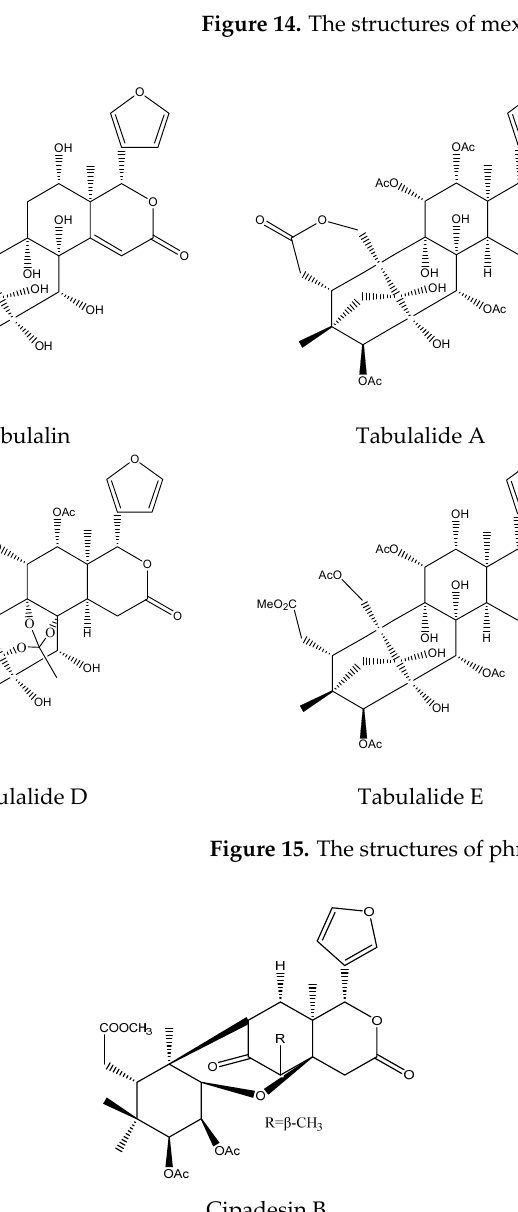
Figure 16. The structure of 10,11-linkage group chemical: cipadesin B.